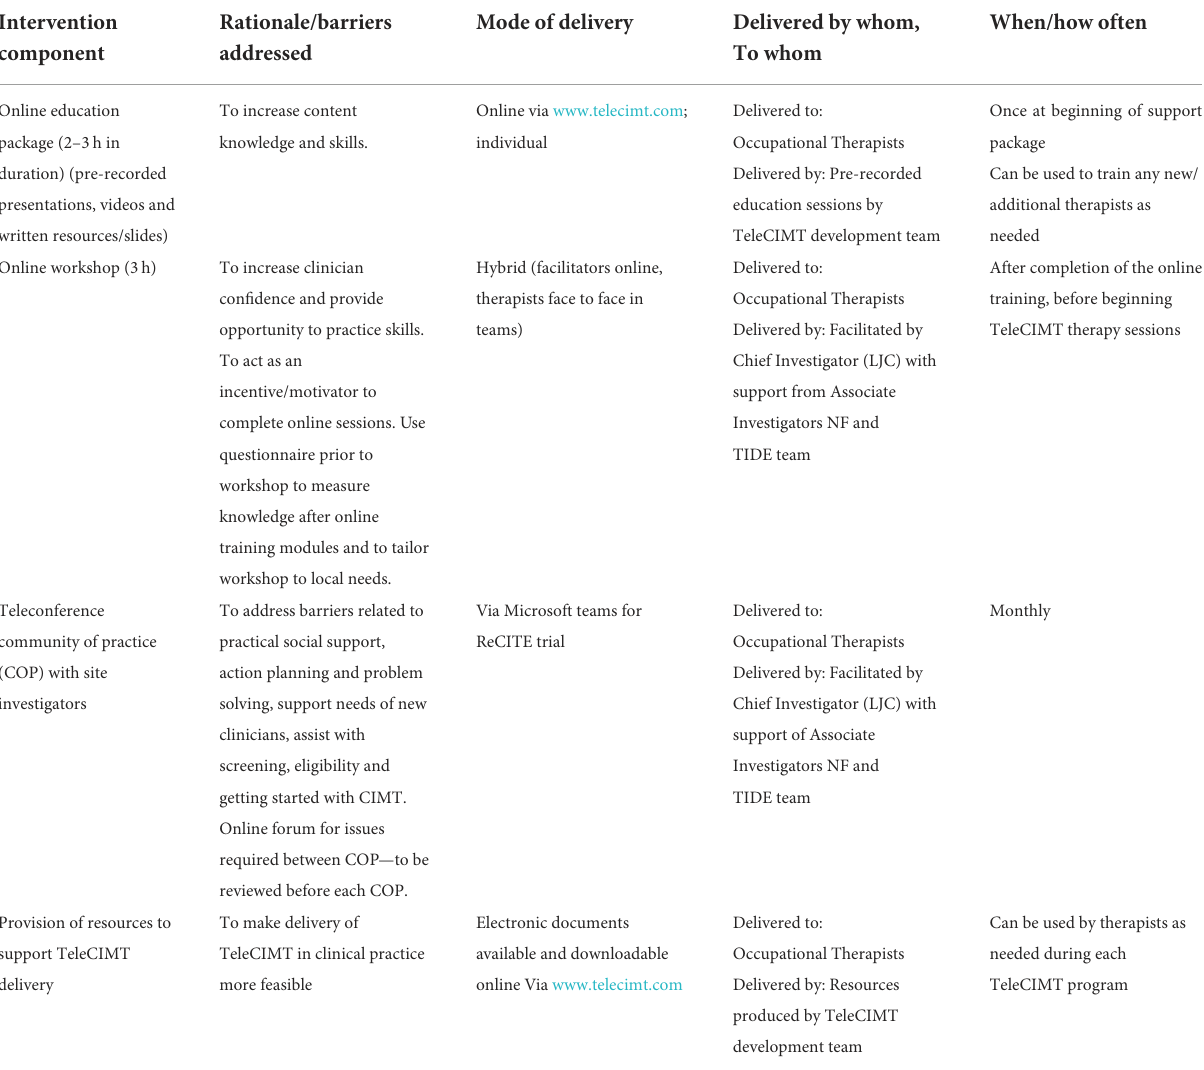
TABLE 1 Description of multicomponent therapist support package delivered to teams of occupational